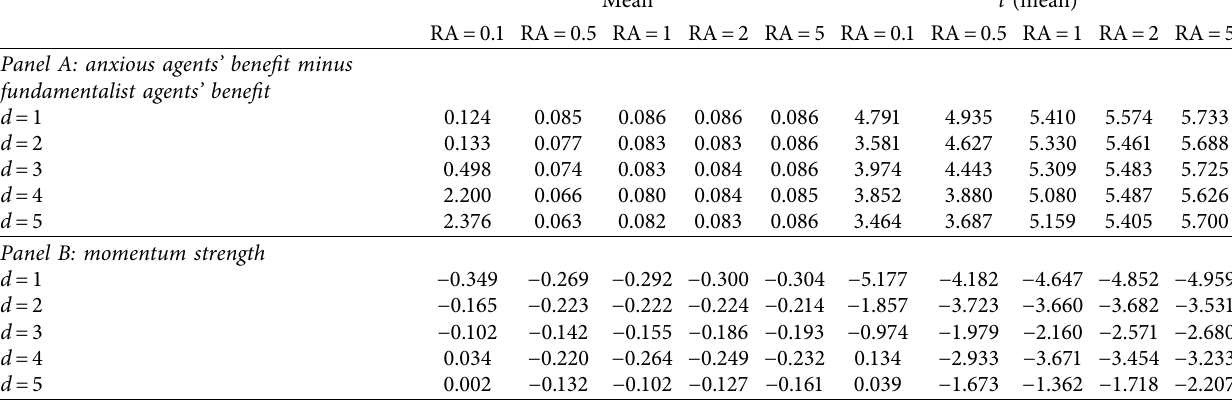
Table 4: Simulations with various degrees of risk aversion. Note: The agents’ benefits and momentum strengths for various degrees of risk aversion in agent evolutions are presented in this table. The indicator of hesitation (represented by d ) lies between 1 and 5. When d equals